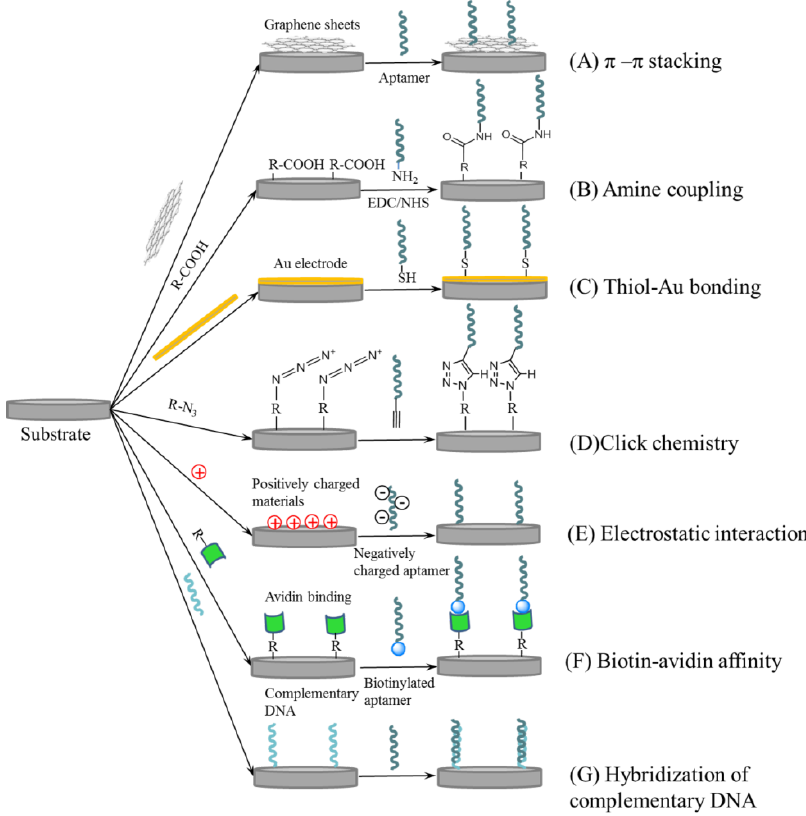
Figure 2. Schematic illustration of different strategies for the modification of electrical interfaces with aptamers.